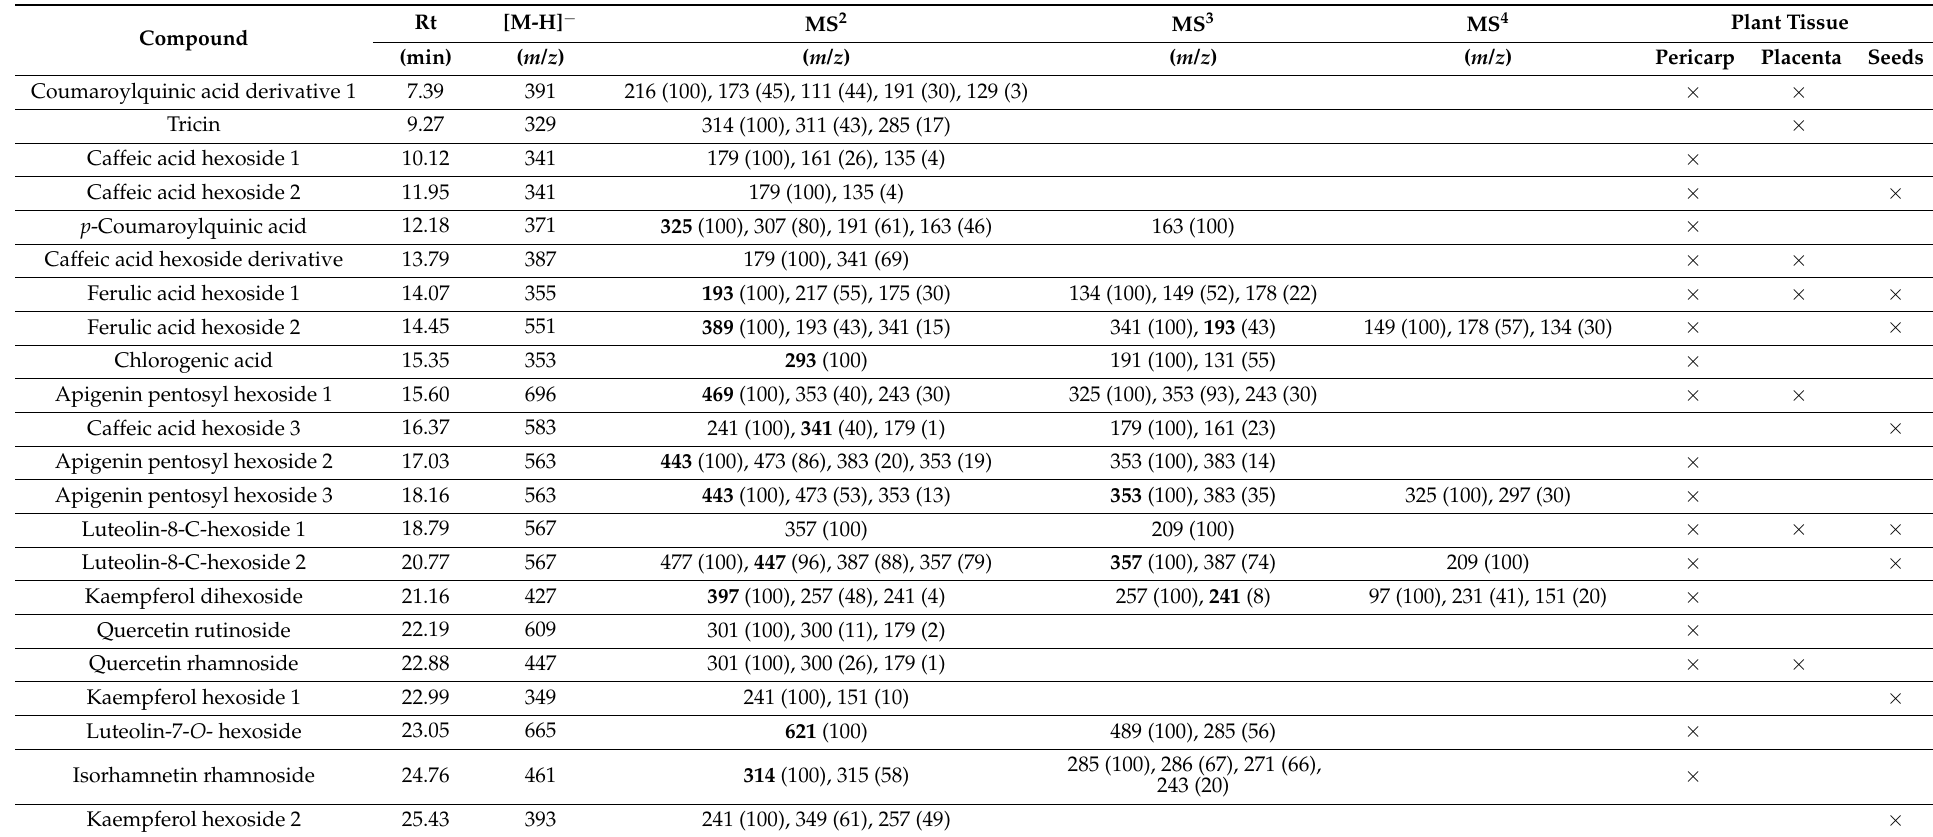
Table 3. The tentative identification of the 22 phenolics from three fruit parts of peppers ( Capsicum annuum